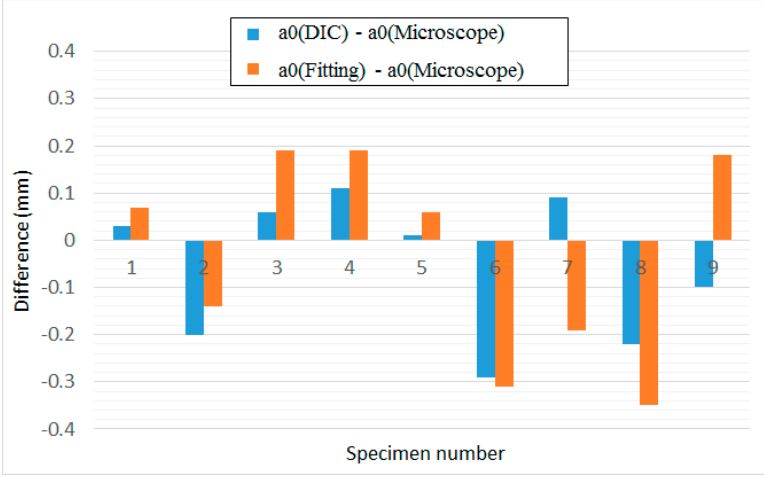
Figure 2. Comparison of initial crack tip positions with different